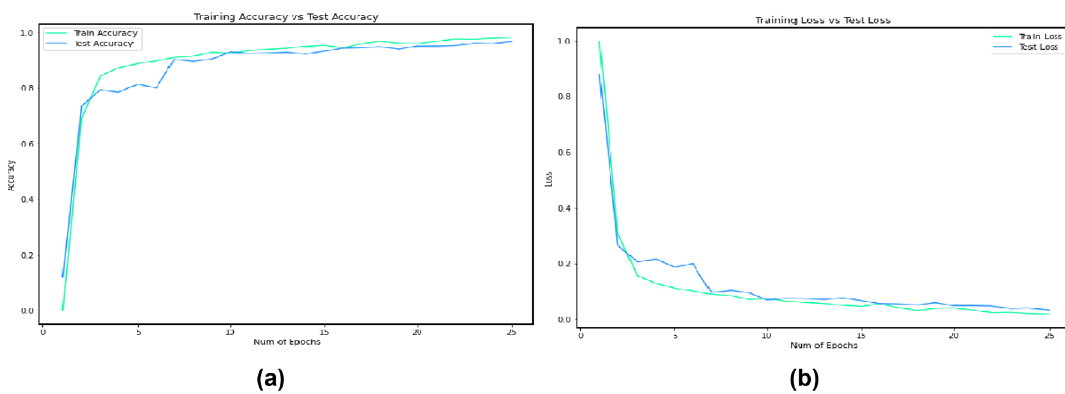
Figure 11. Model Accuracy and Loss while experimenting with original data without augmentation. ( a ) variation of accuracy value with iteration ( b ) change in loss value according to